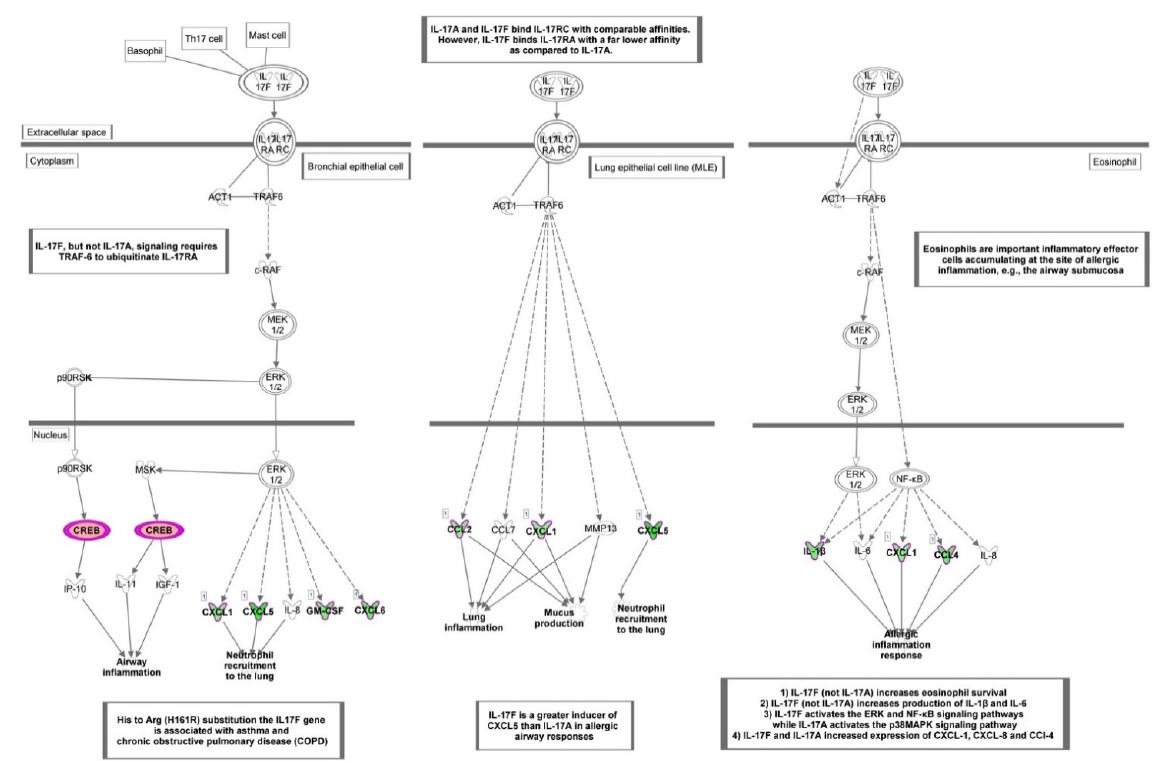
Figure 5. Canonical pathway representing “Role of IL-17F in allergic inflammatory airway diseases” obtained with Ingenuity Pathway Analysis (IPA) from the analysis of data set modulated by HT. Genes which expression was significantly modulated by HT are depicted together with others involved in the cascade (but not significantly modulated, depicted in gray). Complex or groups of genes are surrounded by a double line. Up-regulated genes are depicted in red, and down-regulated genes are depicted in green.